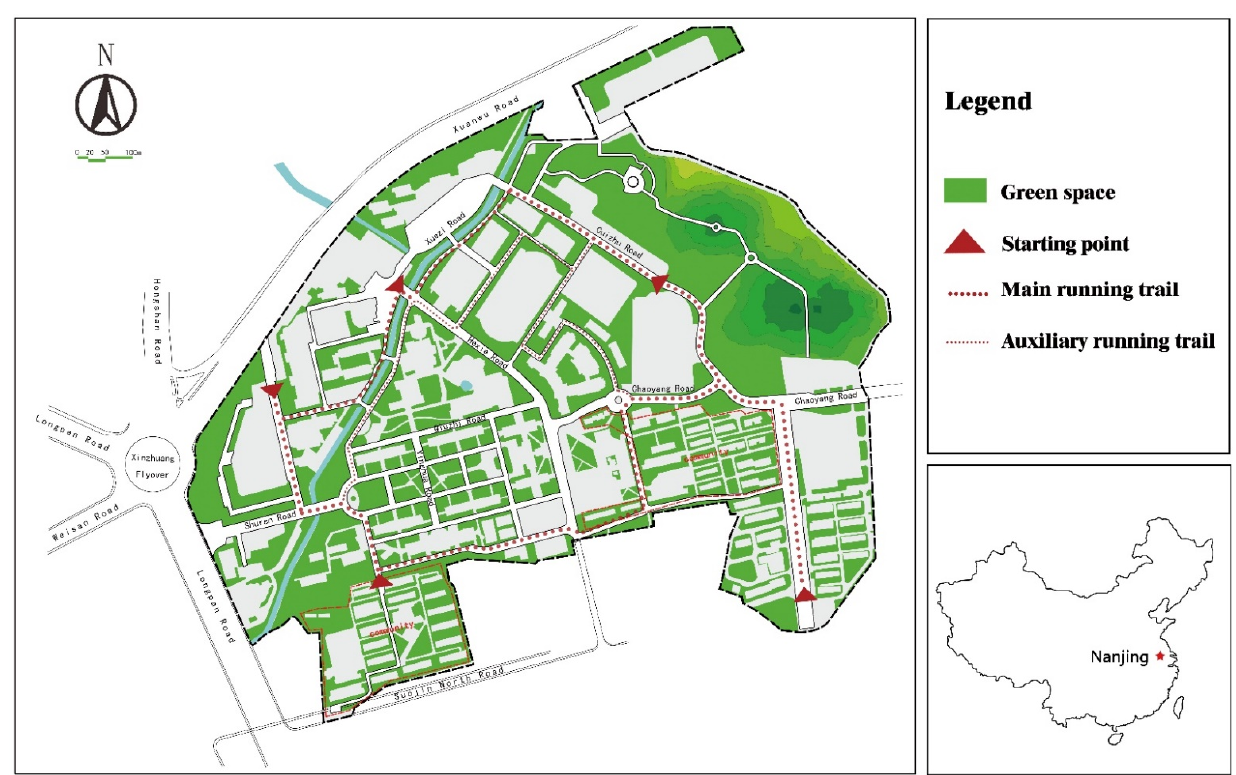
Figure 1. Study area with the trail network.